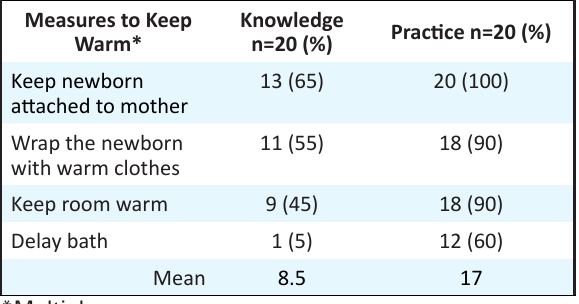
Table 5. Knowledge and Practice on Keeping the Newborn Warm.